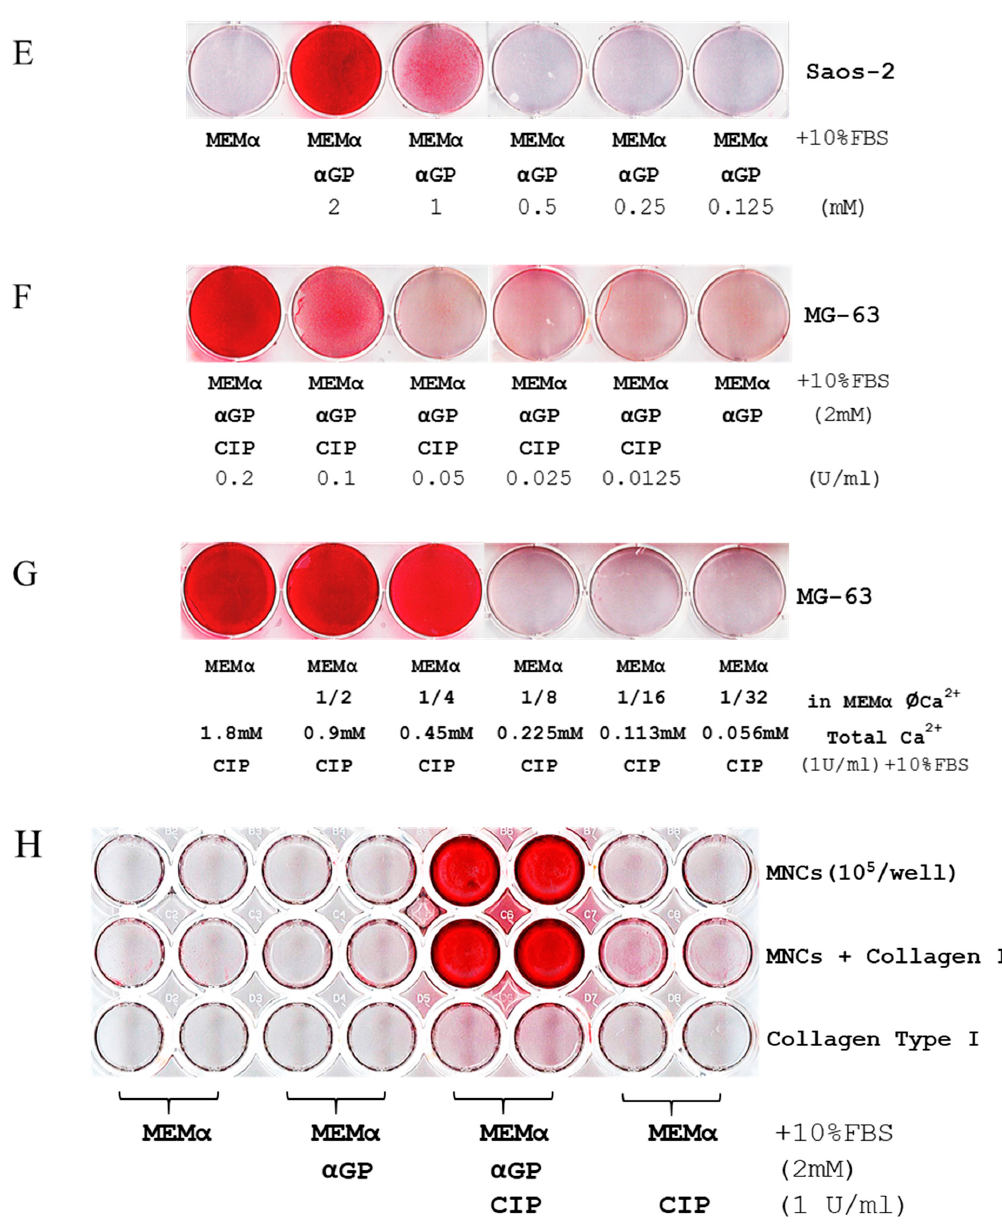
Figure 1. Calcium ion (Ca 2 + ), a phosphoester salt, and alkaline phosphatase (ALP) are essential for promoting biomineralization in MG-63 and Saos-2 cell lines and human blood mononuclear cells (MNCs). ( A ) Alizarin Red S assays (ARS) show mineralization within 7 days, visualized as the intensity of red staining, of Saos-2 cells in MEM α / 10% FBS supplemented only with β GP or the combination of β GP / ascorbic acid (Vit. C) / dexamethasone (Dex); MG-63 cell line was inactive under similar conditions. No mineralization was observed in either cell line cultured with MEM α / 10% FBS supplemented with Vit. C or Dex. In MEM α / 10% FBS supplemented with β GP and ALPL, calf intestinal ALP (CIP), or shrimp ALP (SAP), MG-63 and Saos-2 cell lines were mineralized. ( B ) Similar results were iterated when α GP was used instead of β GP. ( C ) Compared to β GP and phosphoenolpyruvate monosodium (PEP), α GP was the most e ffi cient phosphoester salt elicited biomineralization. Pamidronate (Pamidn) and glycerophosphoric acid (NSC9231) did not elicit the reaction. ( D ) Human MNCs also have an innate ability of mineralization in 7 days without the induction of cellular differentiation (top row